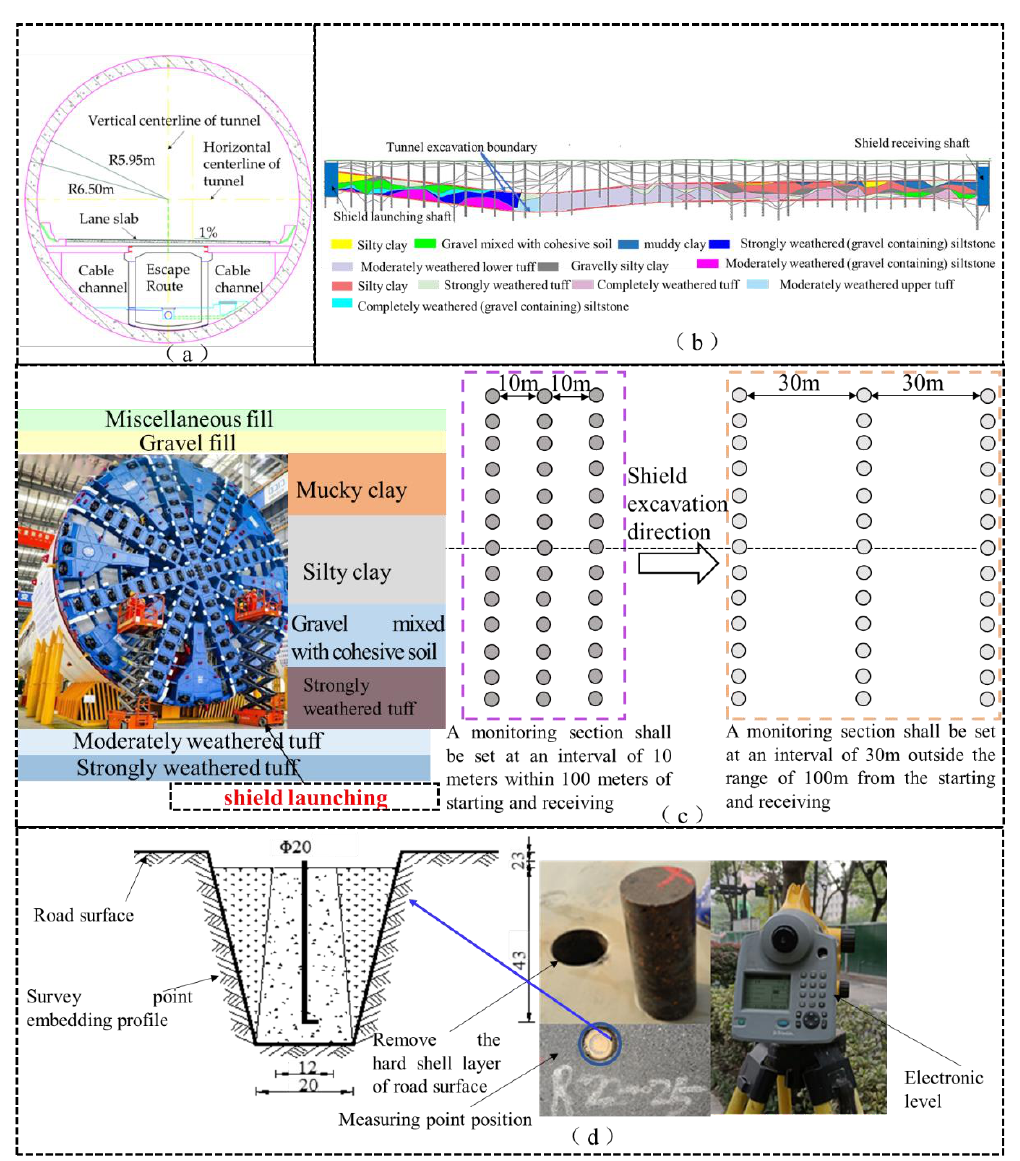
Figure 1. Overview of the shield test section; ( a ) Tunnel design effect diagram; ( b ) Tunnel excavation geology and roadside diagram; ( c ) Measuring point layout diagram; ( d ) Measuring point burying and monitoring construction diagram.